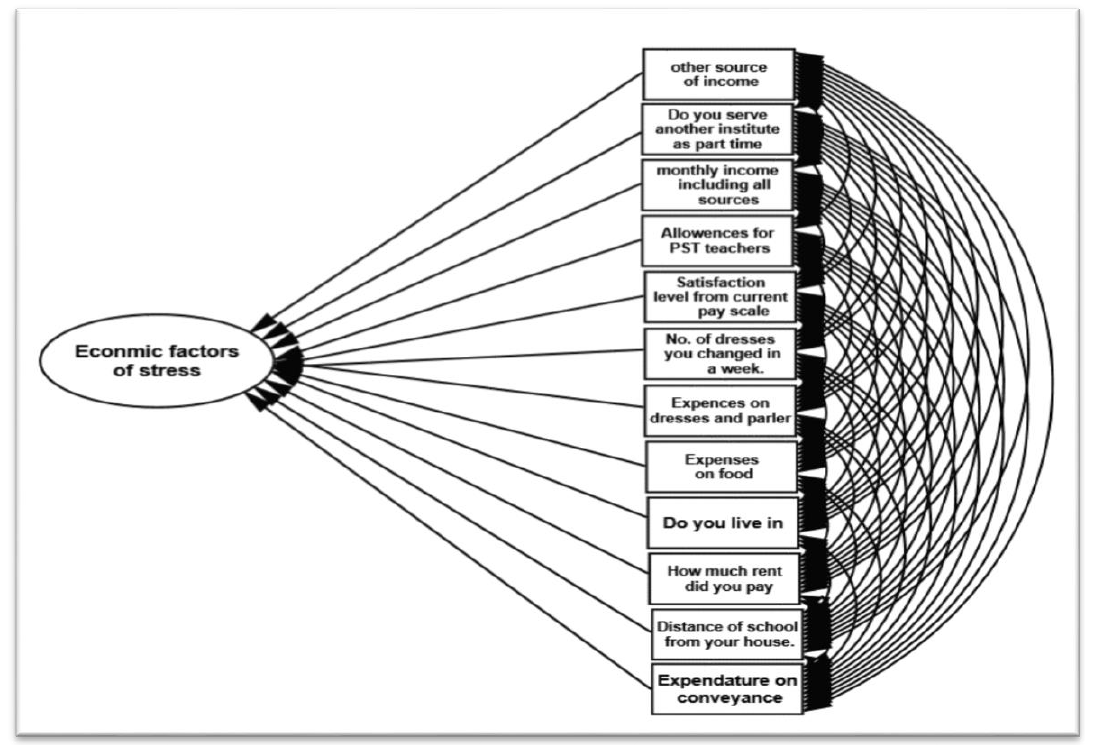
Figure 11. Hypothetical model of economic factors.